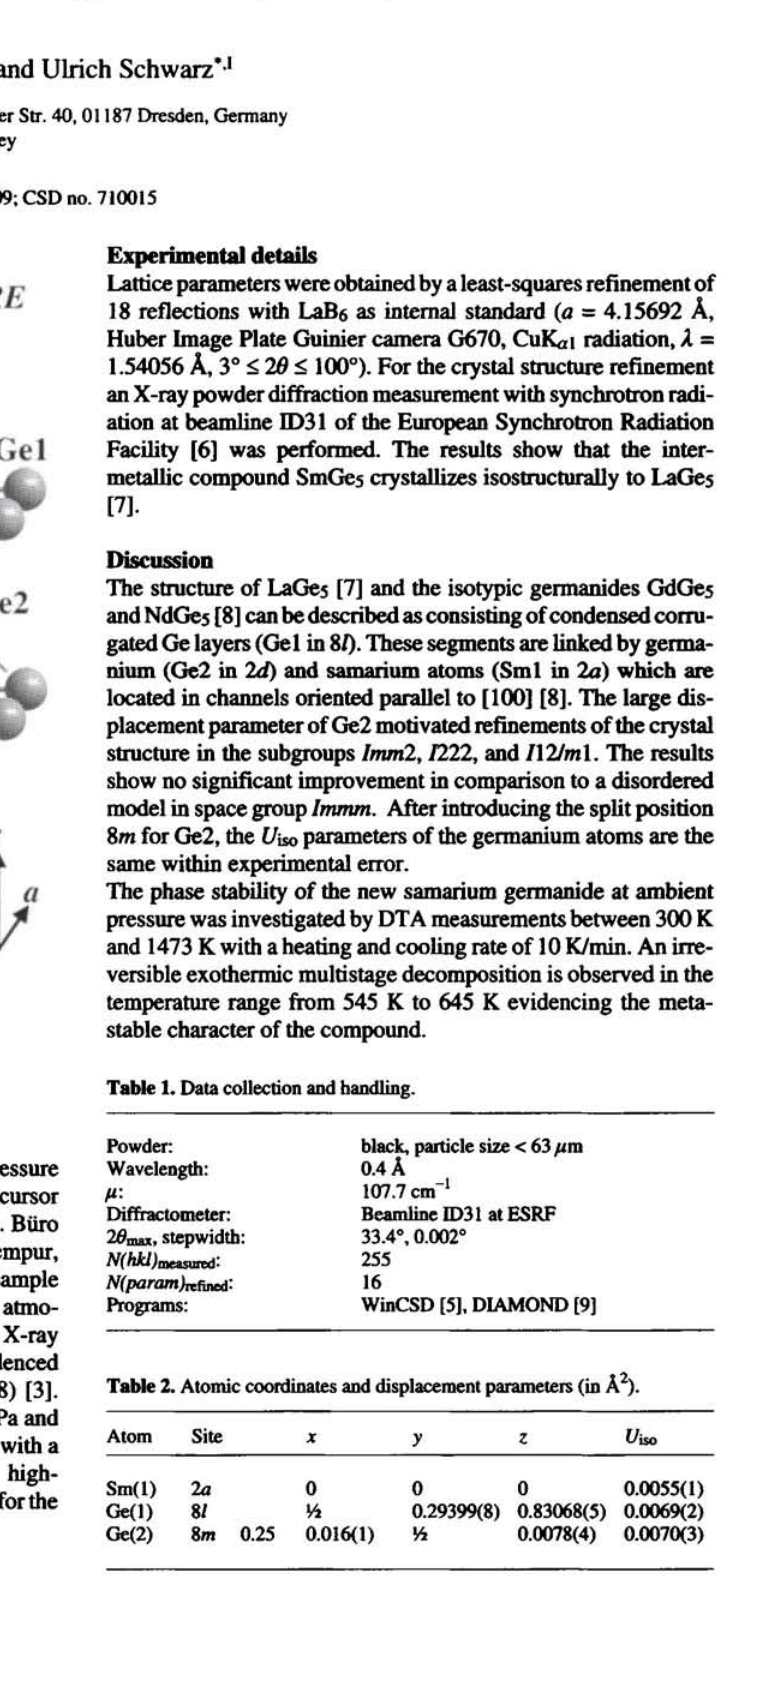
Table 2. Atomic coordinates and displacement parameters (in Â 2